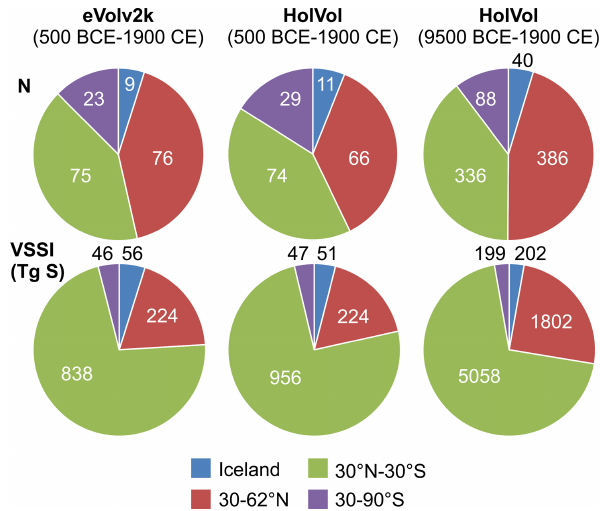
Figure 8. Number of eruptions and cumulative volcanic strato- spheric sulfur injection (VSSI) from eVolv2k (Toohey and Sigl, 2017) and from HolVol for the period of overlap (500BCE– 1900CE) and the full Holocene reconstruction. Only eruptions with VSSI > 1TgS are